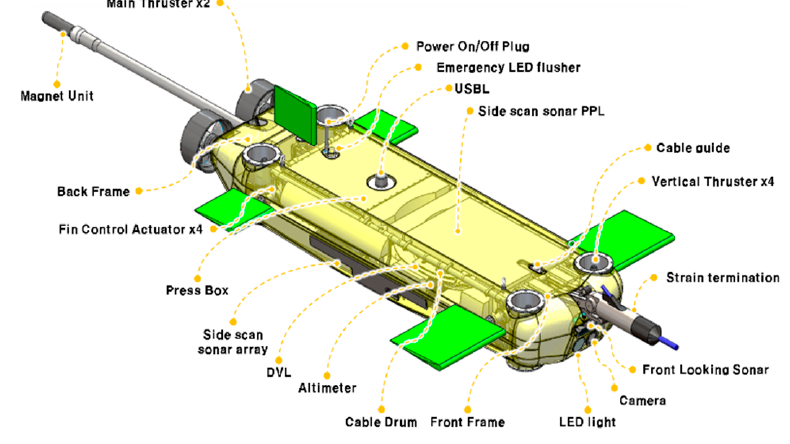
Figure 1. TUP design.